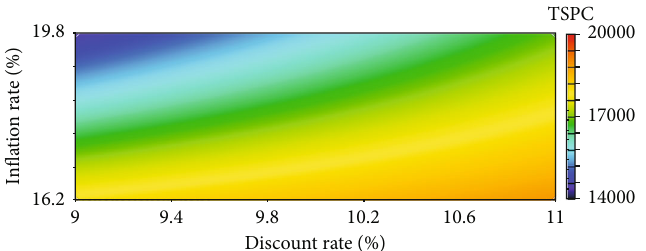
Figure 8: Surface plot of TNPC under scenario 1 with a 20-year vision when considering a ± 10% fl uctuation in discount and in fl ation